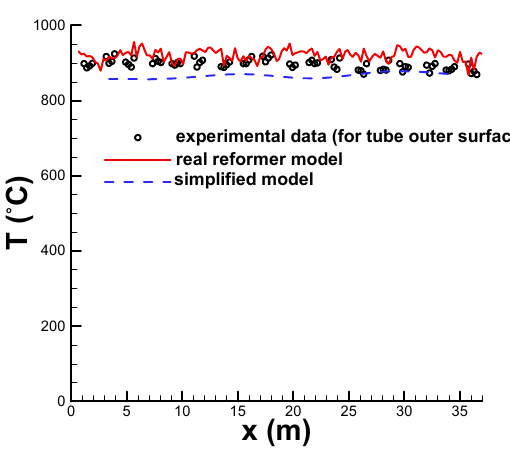
Figure 3. Comparison of the average temperatures at the outer surfaces of the reforming tubes.